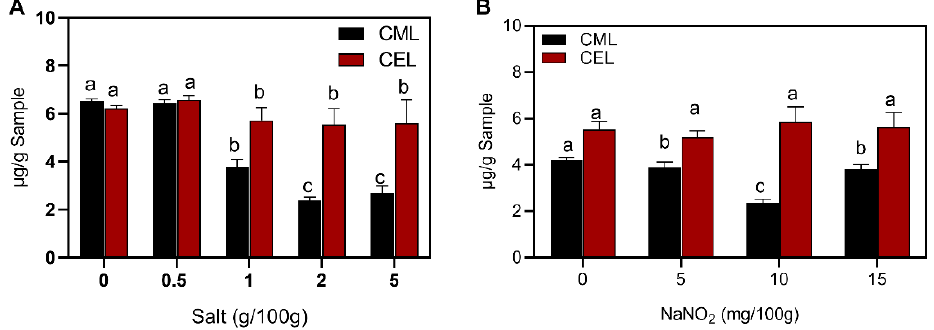
Figure 4. Effect of additive on CML and CEL: ( A ) salt; ( B ) nitrite. Different letters above the bars indicate significant differences (n = 3, p < 0.05). N ε -carboxymethyl lysine (CML) and N ε -carboxyethyllysine (CEL).